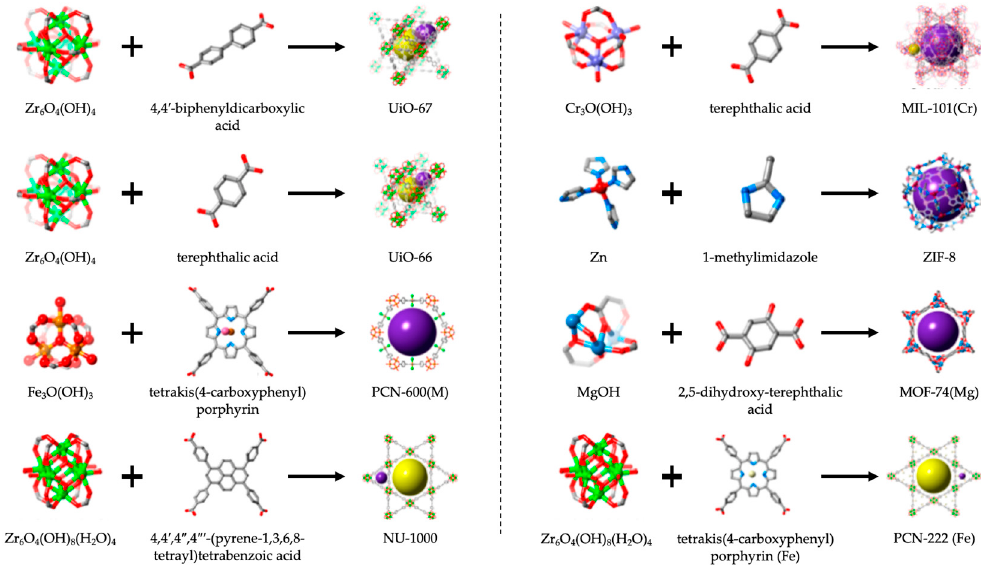
Figure 1. Examples of different metal–organic frameworks structures with their corresponding metallic clusters and organic linkers. Adapted from [18], with permission from American Chemical Society, 2017.